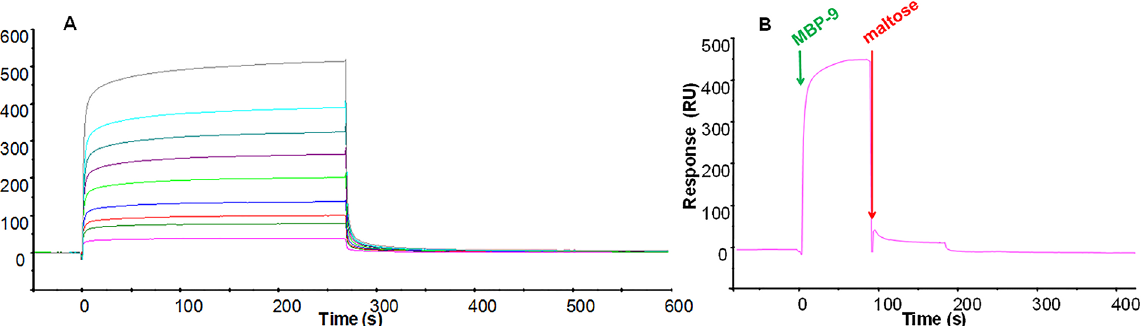
Fig 5. Overlay of SPR sensorgrams for the interaction between the immobilized MBP protein and MBP-9 (A). The experimental curves corresponding to different concentrations of peptides (0 – 800 μ M) were fitted according to a single binding model with 1:1 stoichiometry. Competitive assay between peptides and maltose for immobilized MBP: Sensorgram of the co-injection of MBP-9 peptide at 200 μ M and maltose at 20mM (B).